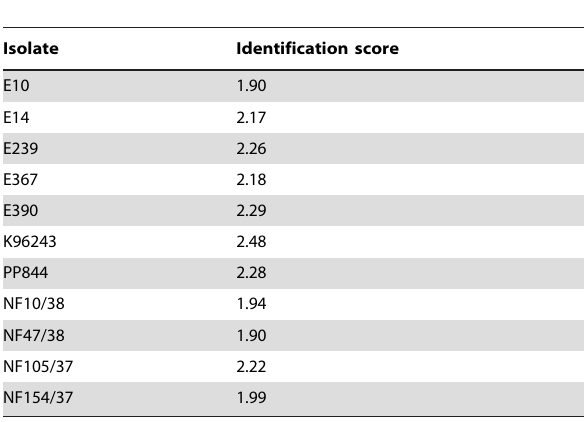
Table 1. Identification scores of all B. pseudomallei